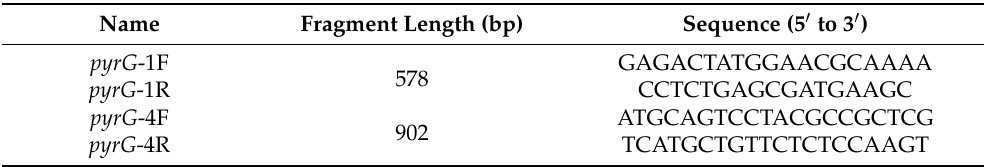
Table 2. List of oligonucleotides used in this